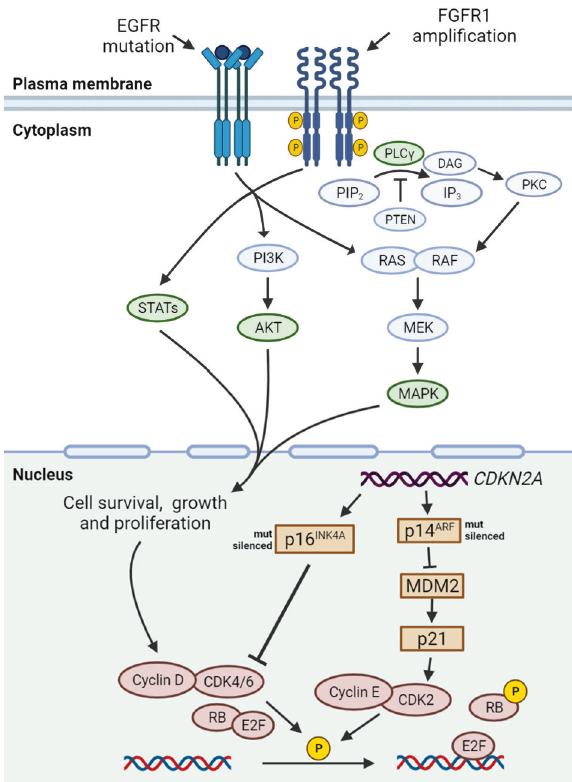
Fig. 2 Mutated driver genes and downstream signal pathways in LSCC. FGFR1 ampli fi cation is observed in 20% of LSCC patients. FGFR1 ampli fi cations can lead to overexpression of wild-type FGFR1 proteins on the cell membrane, resulting in increased sensitivity to FGF and the promotion of tumor growth via increased activation of four key downstream signaling pathways: PLC γ , PI3K-AKT, RAS- MAPK, and STAT (green). Although mutations in EGFR gene are relatively rare in LSCC, in certain cases of LSCC these mutations are responsible for constitutive ligand-independent receptor activation and downstream signaling, promoting cell survival and proliferation. Mitogenic signaling, including activation of upstream PI3K and MAPK signaling, could drive cyclin D upregulation, which leads to CDK4/6 activation. The phosphorylation of RB by cyclin D-CDK4/6 complexes and cyclin E-CDK2 complexes releases E2F transcriptional factors to activate genes required for G1-S transition. The CDKN2A gene encodes p16 INK4A and p14 ARF , which regulate cell cycle by inhibiting CDK4/6 and CDK2, respectively. In LSCC, the inactivated CDKN2A caused by genomic alterations may upregulate this